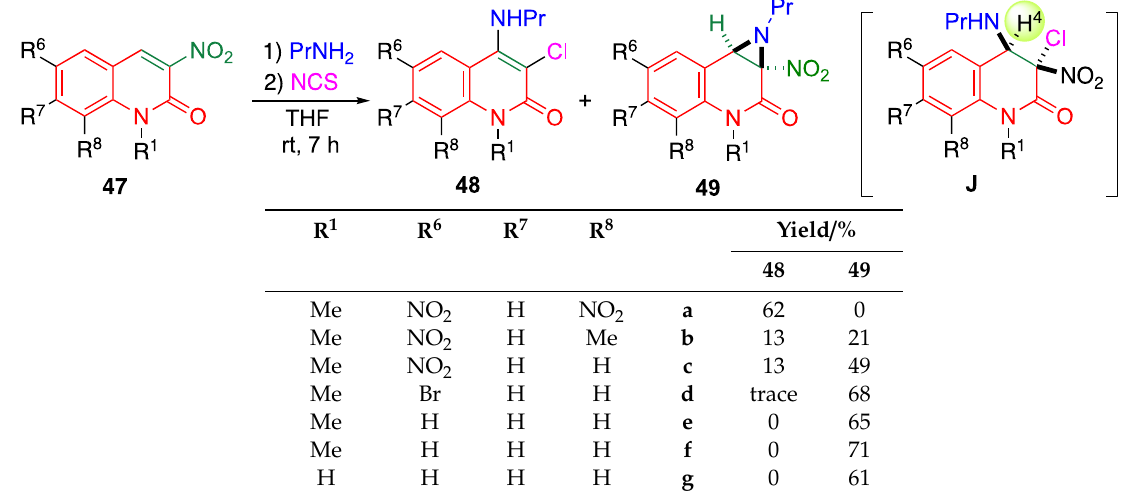
Table 16. Amino-chlorination and aziridination of various 3-nitrated MeQone s.